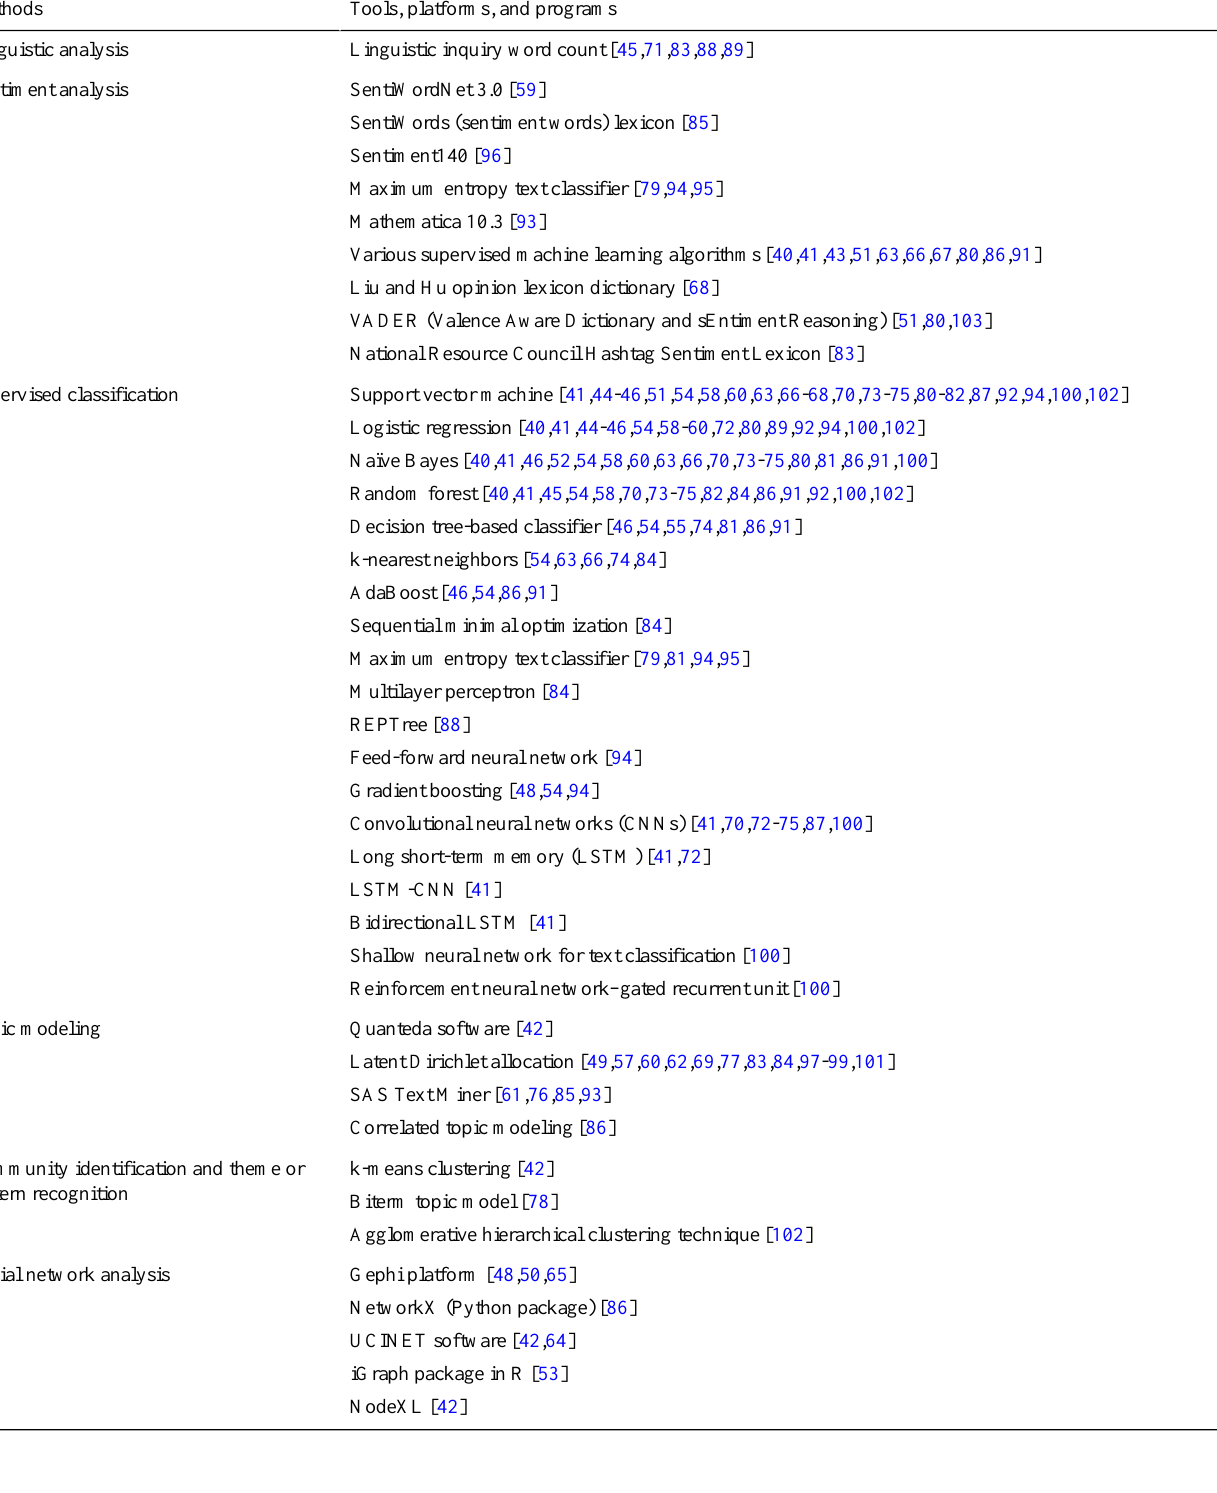
Table 3. Summary of methods and related tools used by various studies. Tools, platforms, and